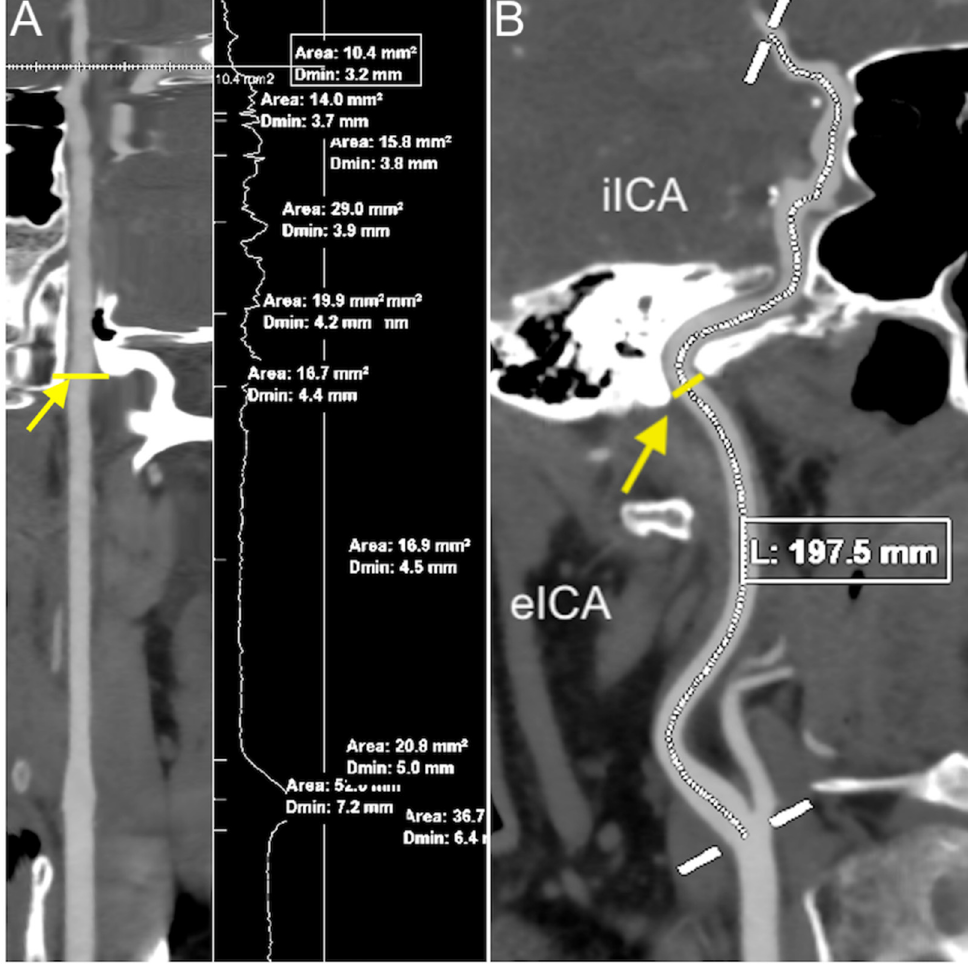
Figure 2. ( A ) Full measurement marks on a rendered stretched vessel image; ( B ) length measurement of the entire ICA on an oblique MIP image; yellow line and arrow in both images = entrance in the carotid foramen. Abbreviations: eICA—extracranial (cervical) part of the ICA; iICA— intracranial part of the ICA; MIP—maximum intensity projection. Table 1. CT angiography morphometric measurements of the entire ICA for all studied patients, stratified by laterality and gender. Results are expressed in millimeters (±standard deviation). Segment Right Side Left Side p -Value